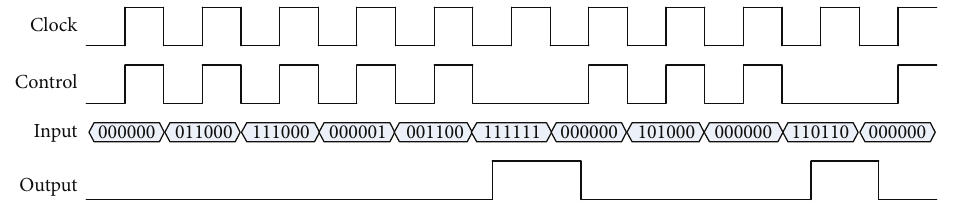
Figure 6: Logic function test for ReRAM-based FPGA. The test is comprised of clock, data control, and input data